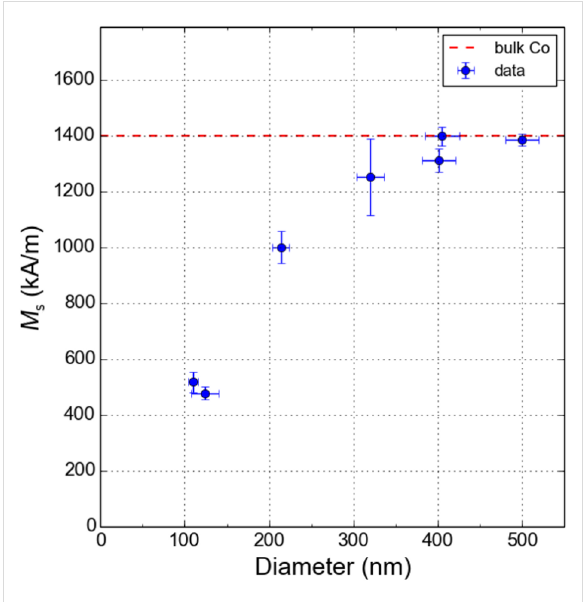
Figure 7: Saturation magnetization of the cobalt nanospheres as a function of their